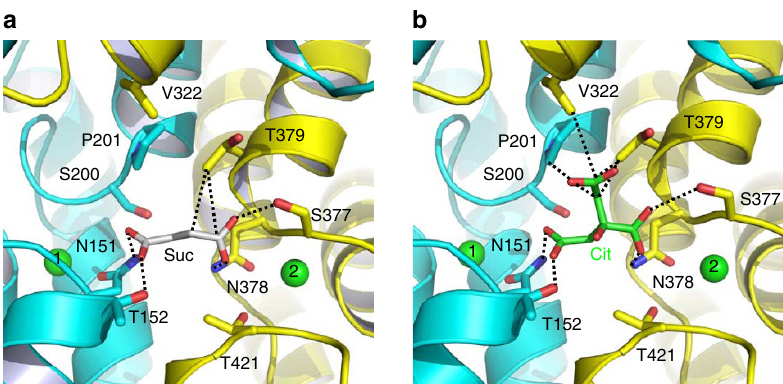
Figure 5 | Close-up views of the succinate- and citrate-binding sites in VcINDY. ( a ) Structure of the succinate-binding site. ( b ) Detailed view of the citrate-binding site. Succinate (grey), citrate (green) and relevant amino acids are drawn as stick models, whereas the Na þ ions are shown as green spheres. Dashed lines highlight the interactions between VcINDY and succinate